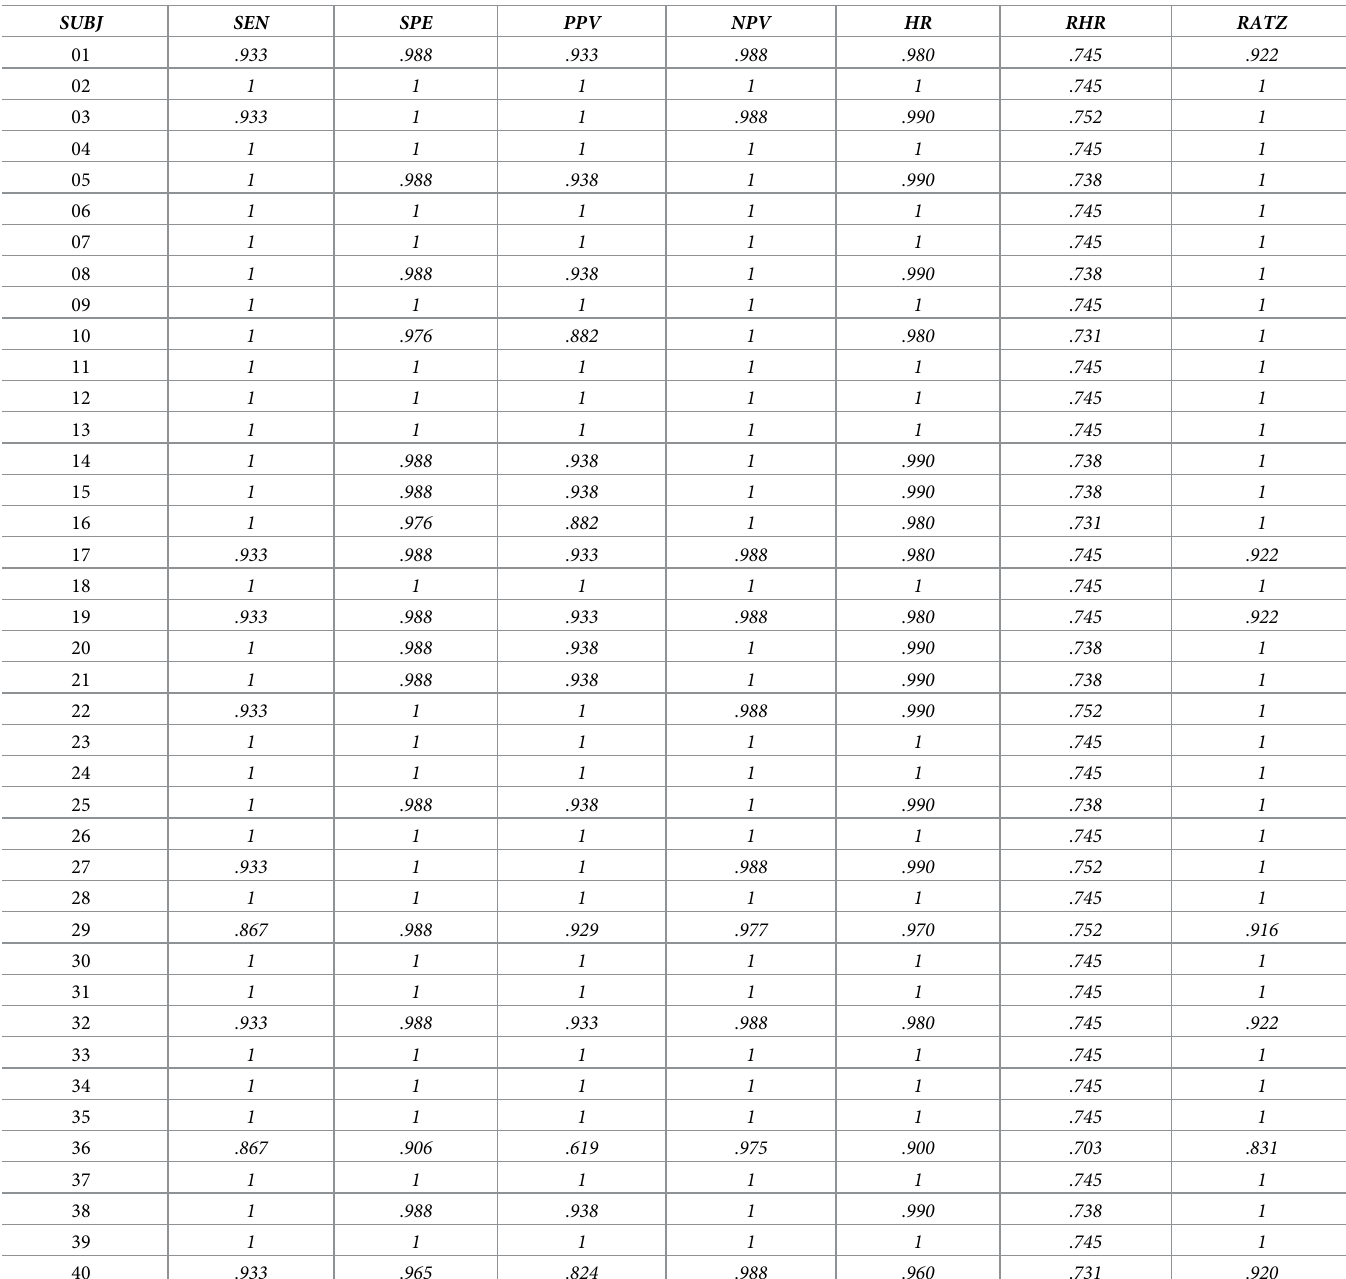
Table 1. Individual test